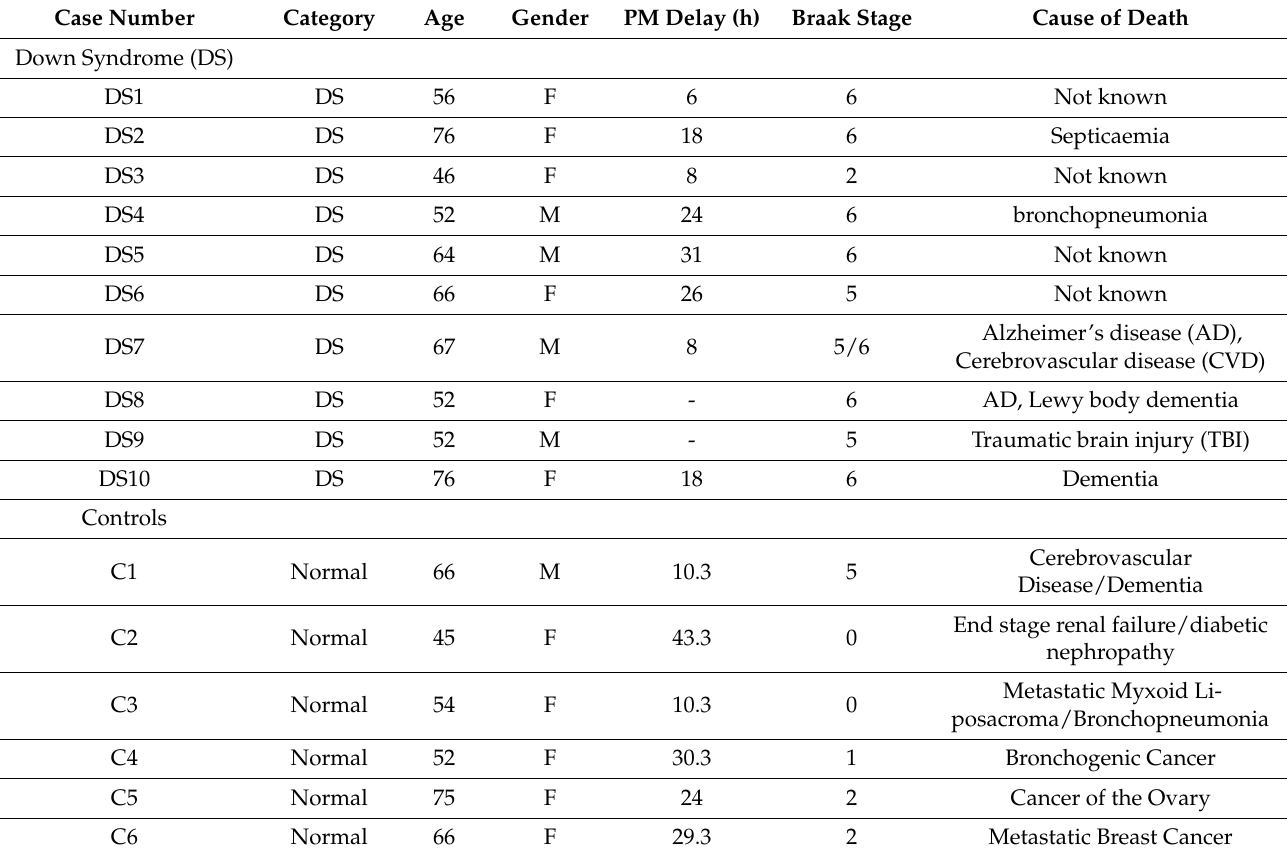
Table 1. Characteristics of post-mortem (PM) brain samples of DS and age-matched control study population, showing age, gender, post-mortem time delay, Braak stages and cause of death. Case